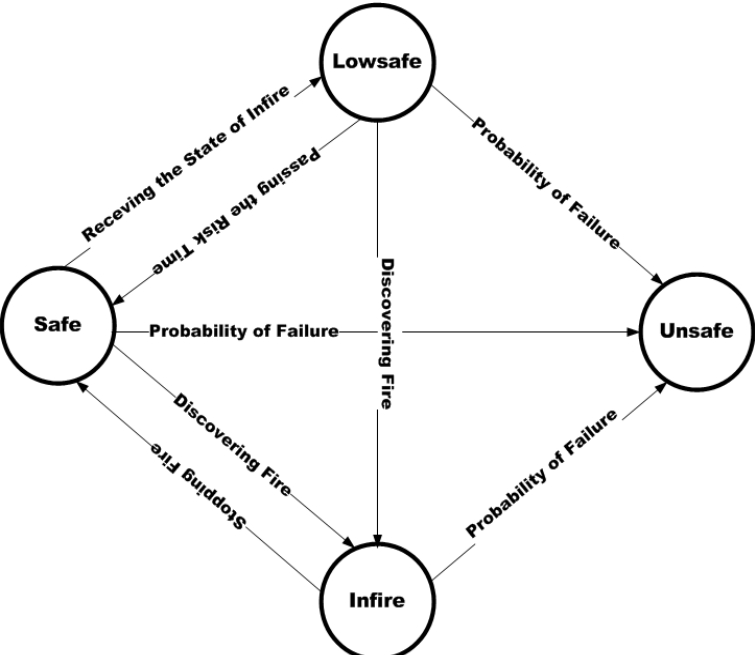
Figure 6. State diagram of the nodes in